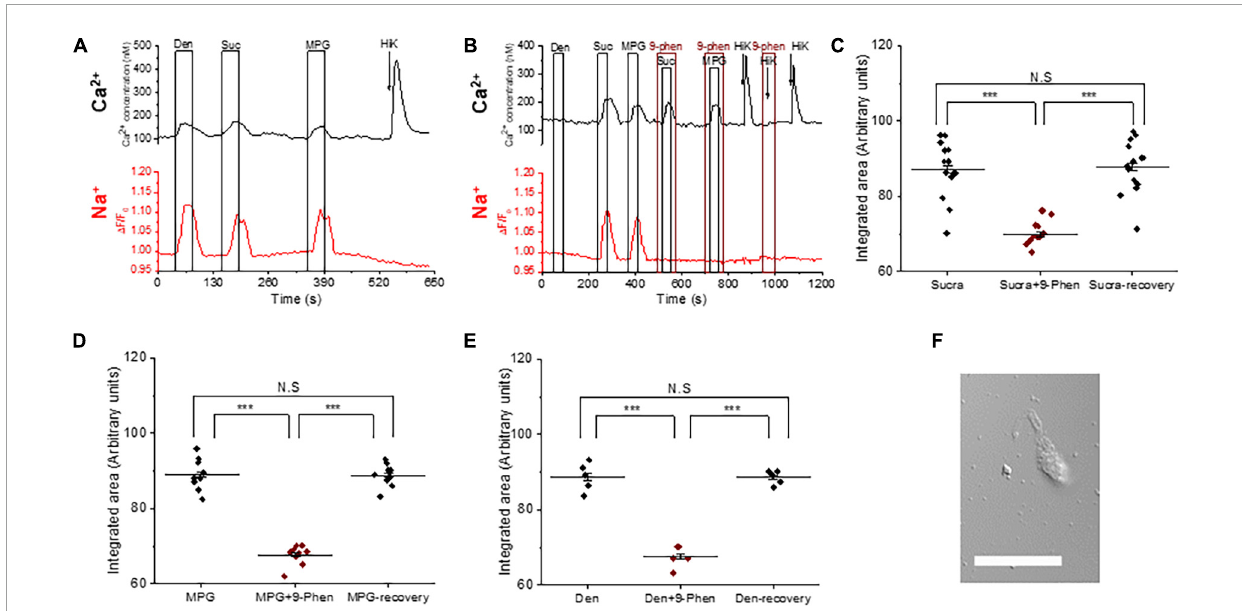
FIGURE1 TRPM4 is solely responsible for the taste-evoked sodium responses in BR Type III cells. (A) Representative dual Ca 2 + (black line) and Na + (red line) imaging traces from BR cells showing cytosolic Ca 2 + and Na + responses to multiple taste stimuli: bitter (5 mM denatonium), sweet (10 mM sucralose), and umami (20 mM MPG). (B) Taste-evoked Na + responses were eliminated by 9-phenanthrol, a selective TRPM4 inhibitor, in BR cells. The magnitudes (integrated area) of the taste-evoked Ca 2 + responses were significantly reduced by 9-phenanthrol in BR cells for different stimuli: (C) sweet ( F ( 2 , 39 ) = 33.41, p = 0.0000000035, n = 14 cells from 5 mice), (D) umami ( F ( 2 , 24 ) = 120.83, p = 0.0000000000003, n = 9 cells from 5 mice), and (E) bitter ( F ( 2 , 12 ) = 85.43, p = 0.00000008, n = 5 cells from 3 mice) (*** P < 0.001; N.S = Non-significant). (F) A DIC image of a representative taste receptor cell. Scale bar = 20 µ